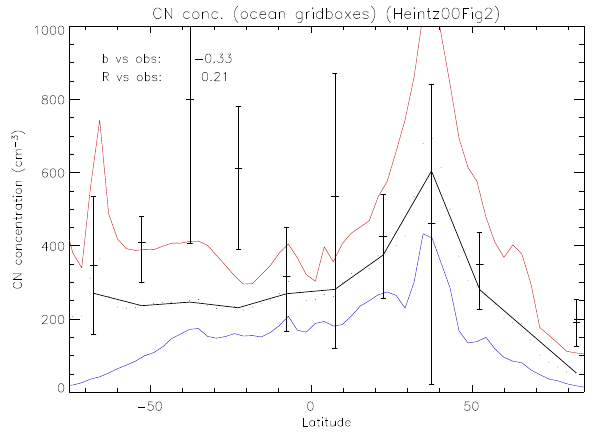
Fig. 17. Simulated marine zonal mean surface CN concentra- tions (solid lines) compared to an observed climatology over sev- eral field campaigns (Heintzenberg et al., 2000). Model values are from the lowest model level over ocean averaged into 15- degree latitude ranges to match the observations. The black line shows the model annual mean and the red/blue lines show mini- mum/maximum monthly-mean values. Values of R and b are also